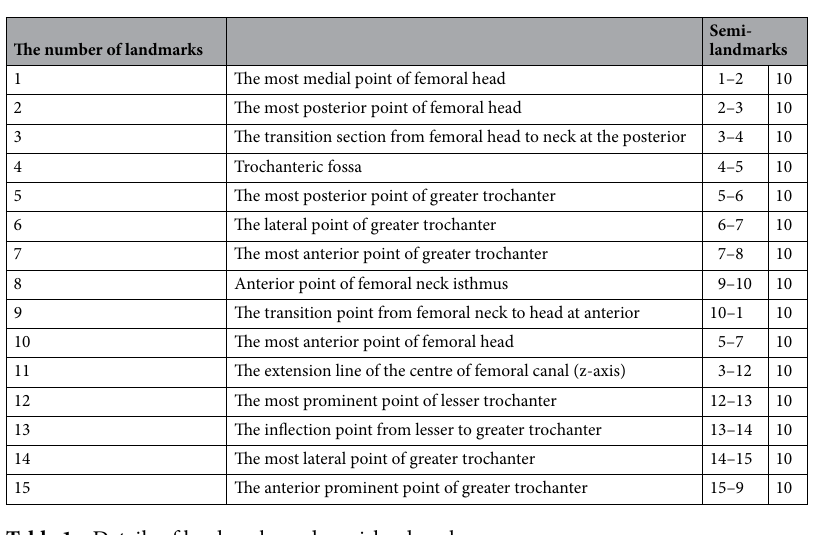
Table 1. Details of landmarks and semi-landmarks.